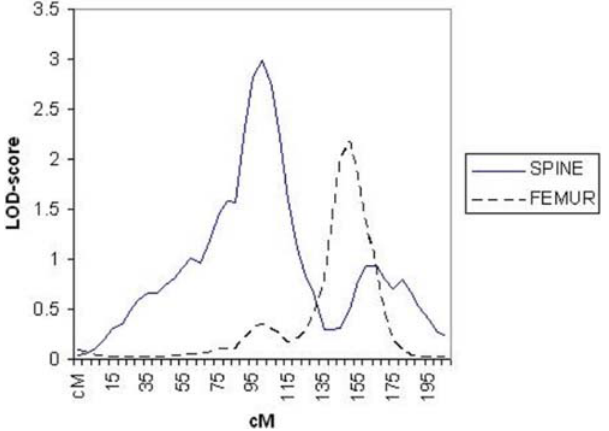
Figure 3. Linkage Results for Spine & Femur on Chromosome 5 at 105cM and 155cM respectively. LOD-scores are compared on chromosome 5 for spine length residuals (LOD=3.00) and femur length (LOD=2.19) at 105cM and 155cM respectively.